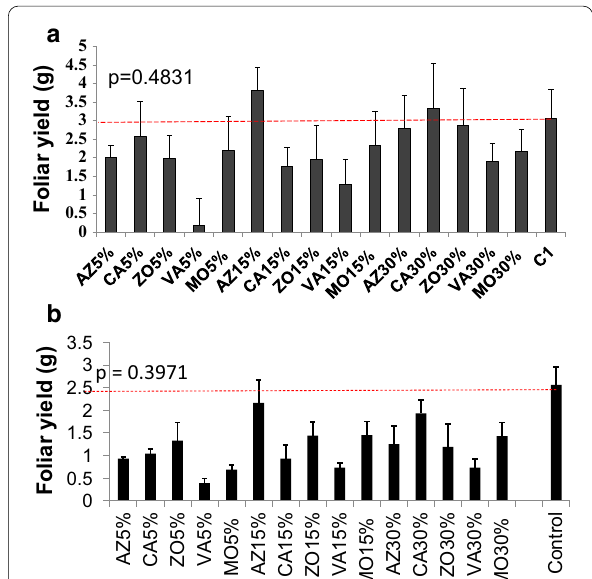
Fig. 5 a Foliar yield of N-rice plants at 12 weeks after sowing in